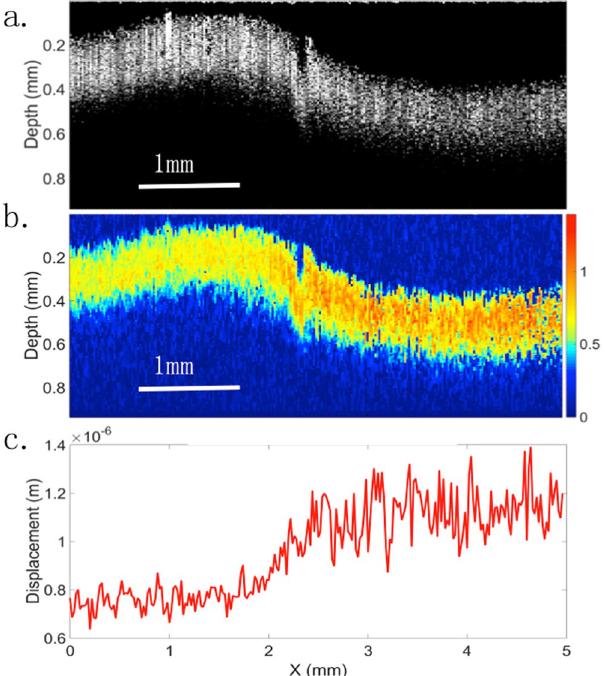
Figure 4. Side by side phantom. ( a ) OCT structural image. ( b ) OCE elastogram. ( c ) Average displacement